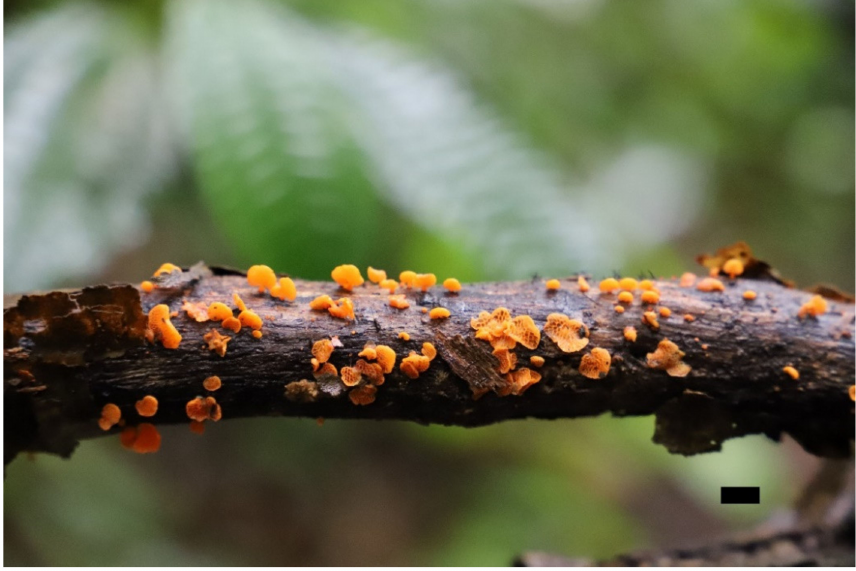
Figure 13. Fresh basidiocarps of Favolaschia minutissima (Holotype). Scale bar = 10 mm.